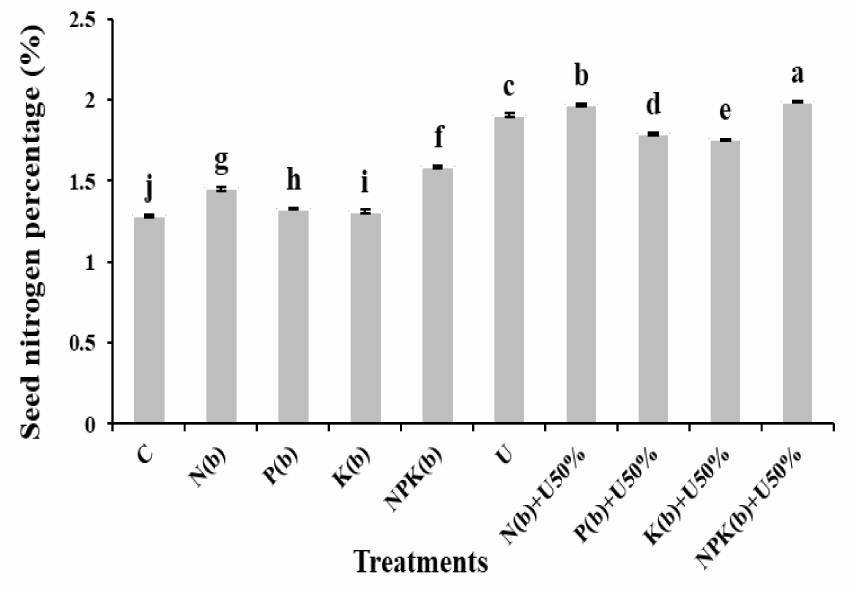
Figure 7. Means comparison for seed nitrogen percentage of Nigella sativa L. as influenced by biofertilizers and chemical urea. Different letters indicate a significant difference according to PLSD test with 3 replications at the p ≤ 0.05 (chemical urea fertilizer (U), biofertilizer N (b) , biofertilizer P (b) , biofertilizer K (b) , mixed biofertilizer NPK (b) , 50% urea + biofertilizer N (N (b) + U 50% ), 50% urea + biofertilizer P (P (b) + U 50% ), 50% urea + biofertilizer K (K (b) + U 50% ), and 50% urea +